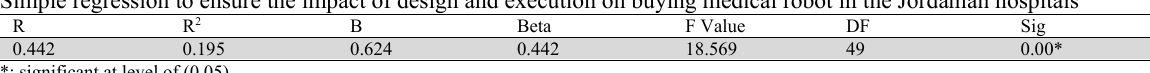
Simple regression to ensure the impact of design and execution on buying medical robot in the Jordanian hospitals R R